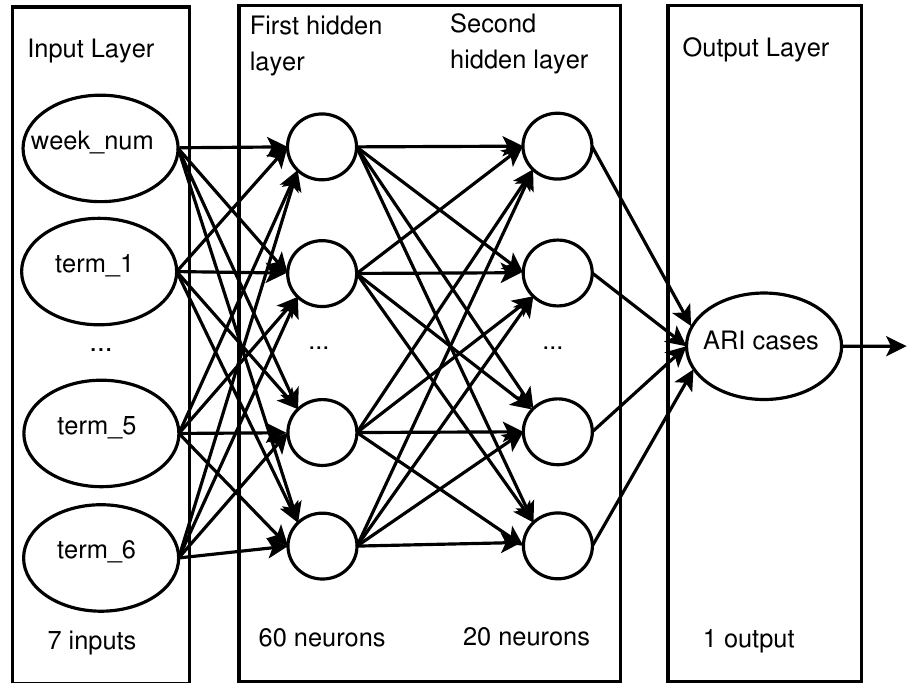
Figure 5. Feedforward Neural Network (FFNN)